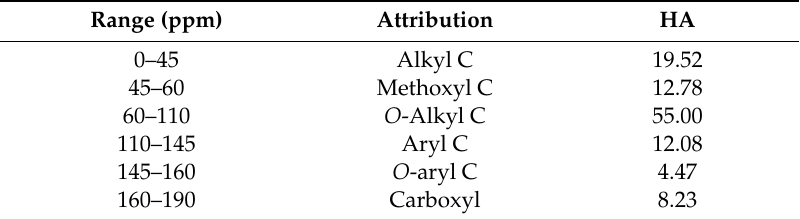
Table 2. Relative C distribution (%) in the chemical shift regions (ppm) in the 13C-CPMAS -NMR spectrum of HA isolated from mature manure-made compost.